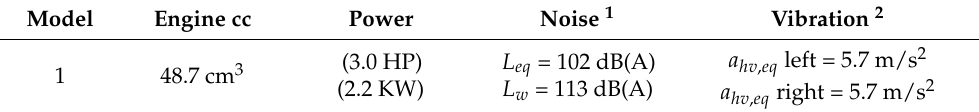
Table 2. Measured machine. Noise and vibration values declared by the manufacturer.